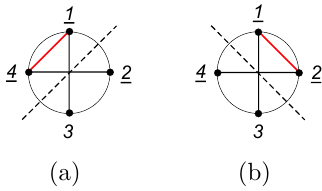
, (b) Pf A 12 14 12